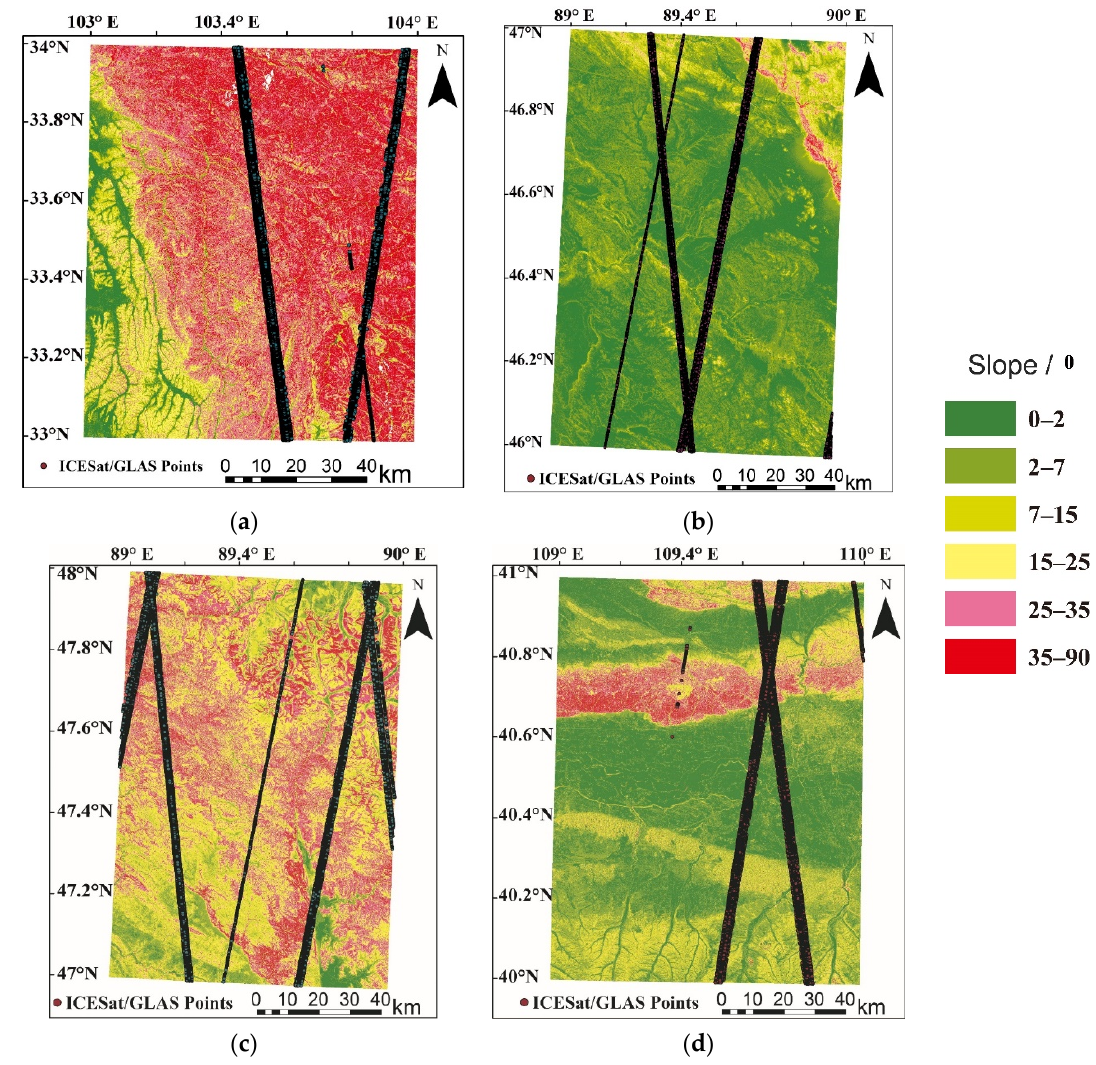
Figure 6. The spatial distribution of slopes in four study areas and the distribution of ICESat/GLAS points: ( a ) Sichuan; ( b ) Xinjiang A; ( c ) Xinjiang B; and ( d ) Inner Mongolia.